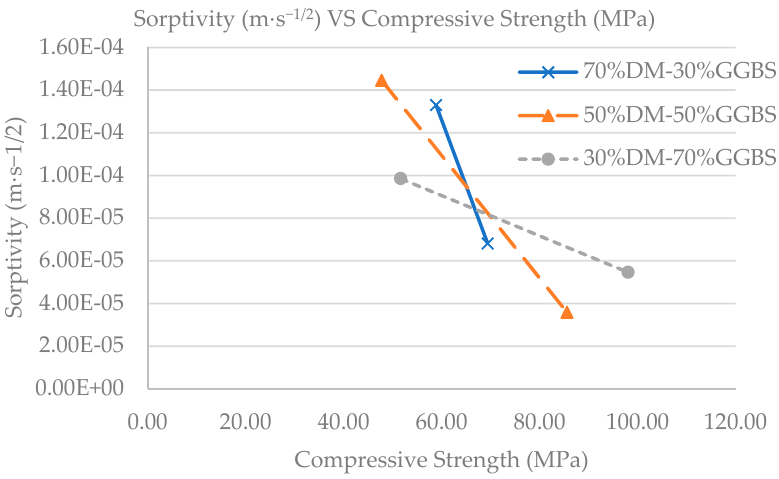
Figure 11. Sorptivity vs. Compressive Strength per Geopolymer Mixture.